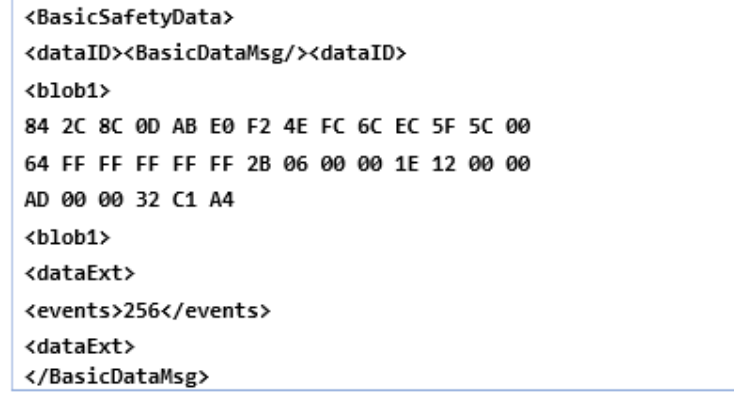
Figure 36. Basic security message structure.